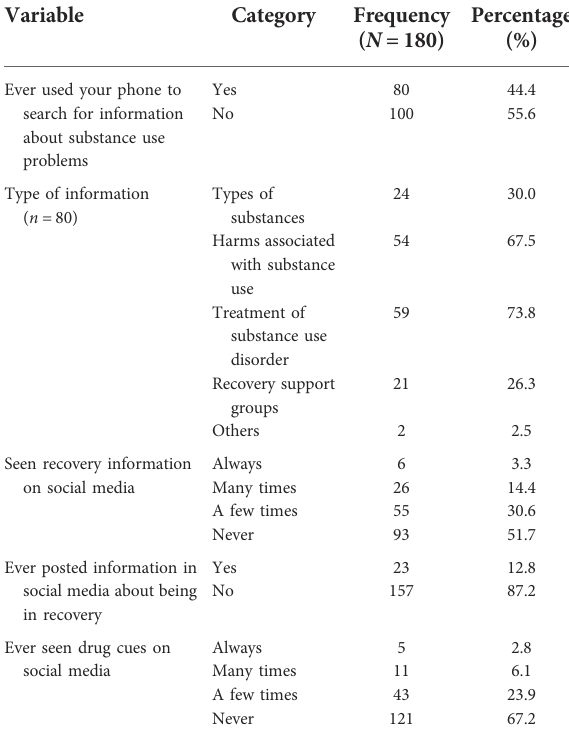
TABLE 2 Table showing summary of mobile phone ownership and technology use among